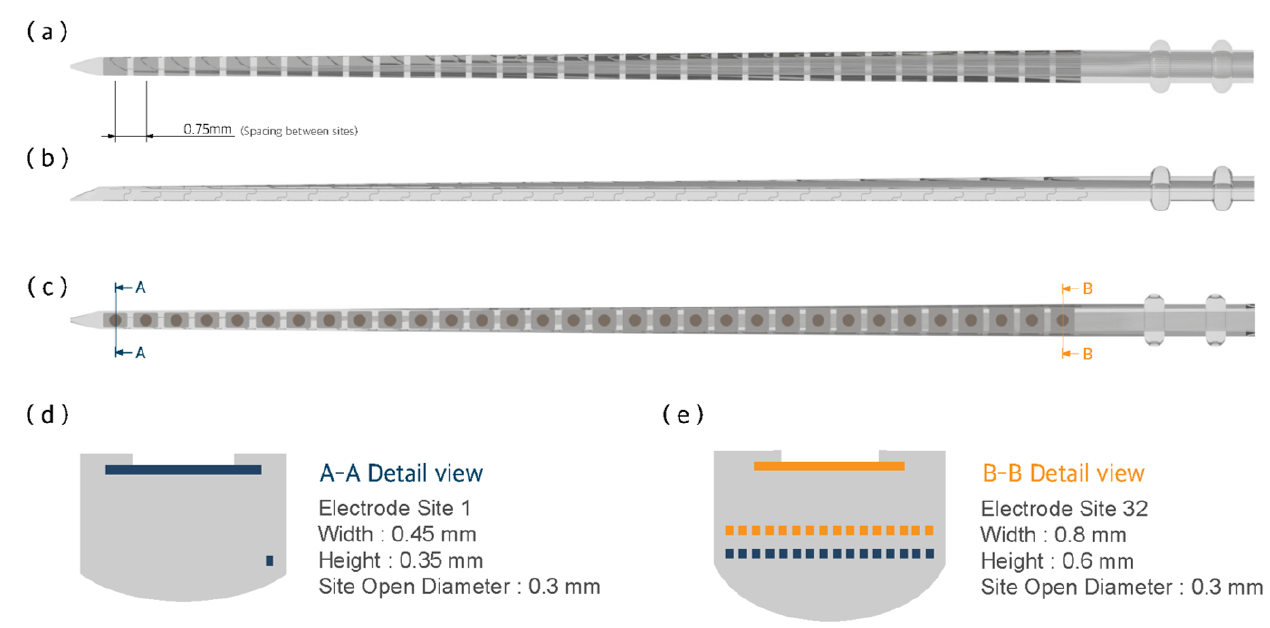
Figure 1. Design and structure of the proposed 32-channel electrode array. Images of ( a ) bottom; ( b ) side; and ( c ) top views of the electrode array. The cross-sectional images show the electrodes and the arrangement of the lead wires; ( d ) The cross-sectional view of the 1st electrode site from the apex. There is only one electrode contact and one lead wire inside the silastic carrier; and ( e ) the cross-sectional view of the 32nd electrode site from the apex. The 32nd electrode contact and 32 lead wires are inside the silastic carrier. The 32 lead wires are arranged in a 2 × 16